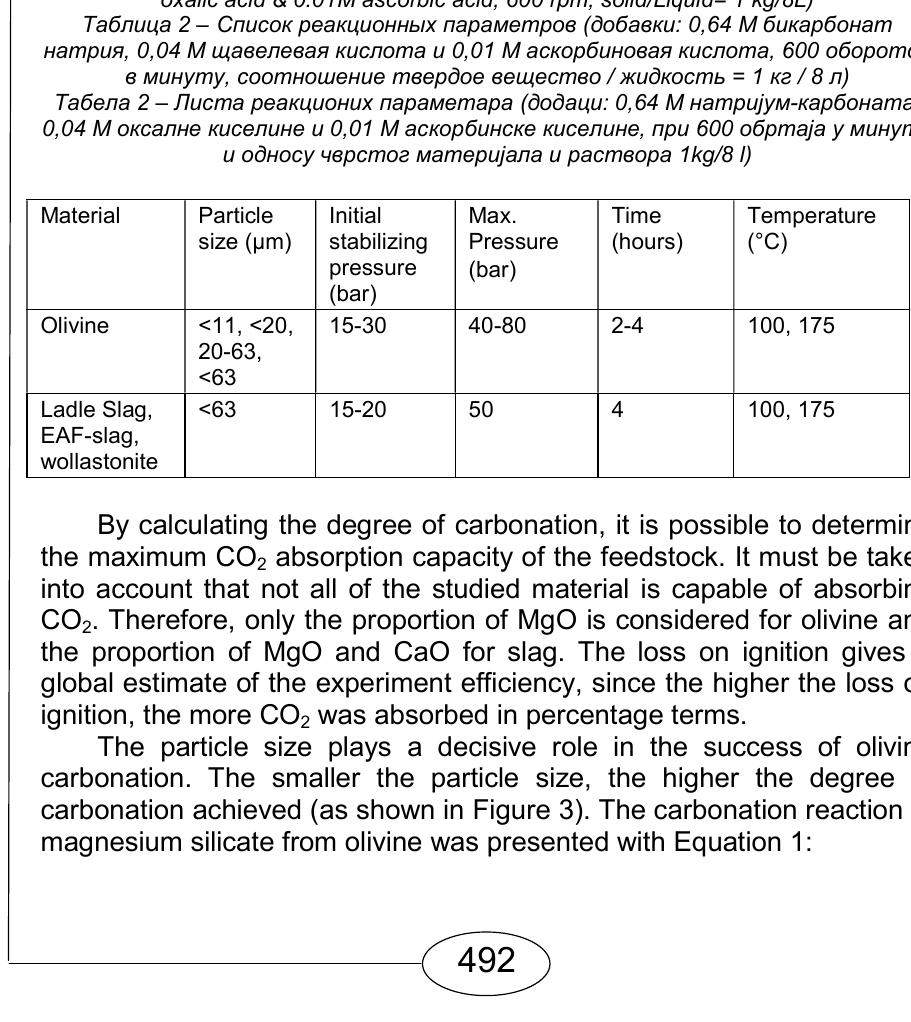
Table 2 – List of the reaction parameters (Additives: 0.64 M sodium bicarbonate, 0.04